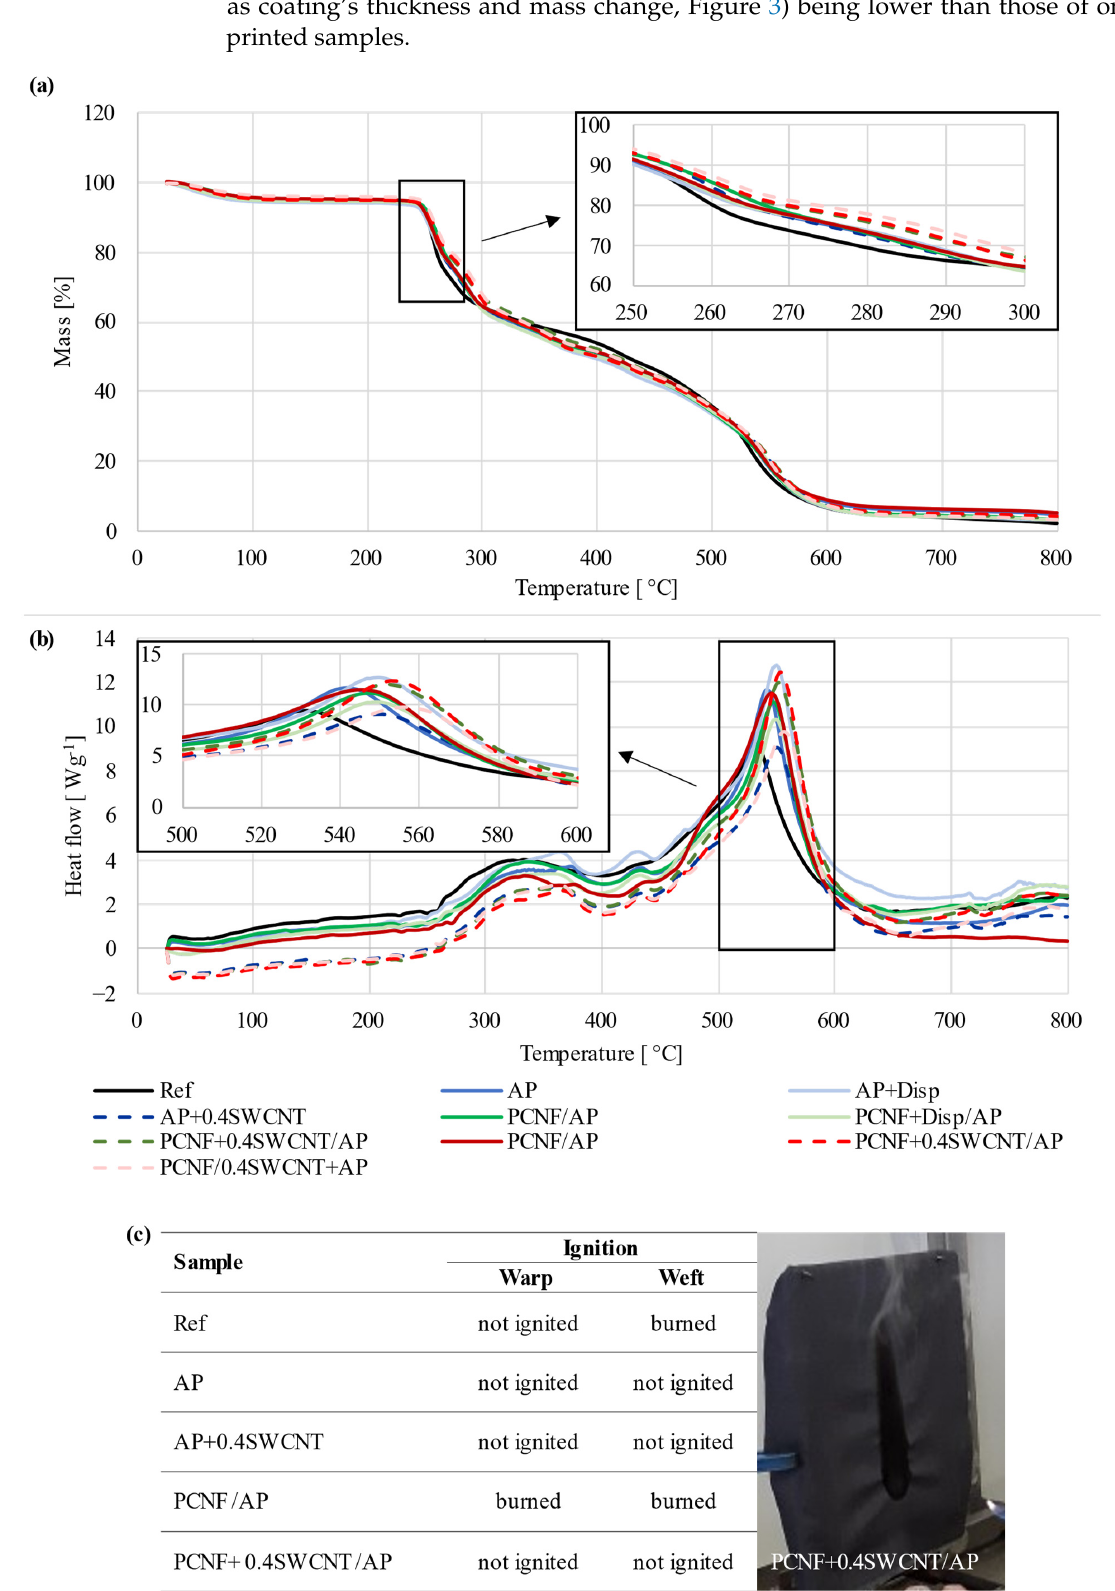
Figure 6. ( a ) The effect of printing on the fabric’s: ( a ) Thermogravimetric (TGA), ( b ) Differential scanning calorimetry (DSC), and ( c ) Flame-resistant analysis.